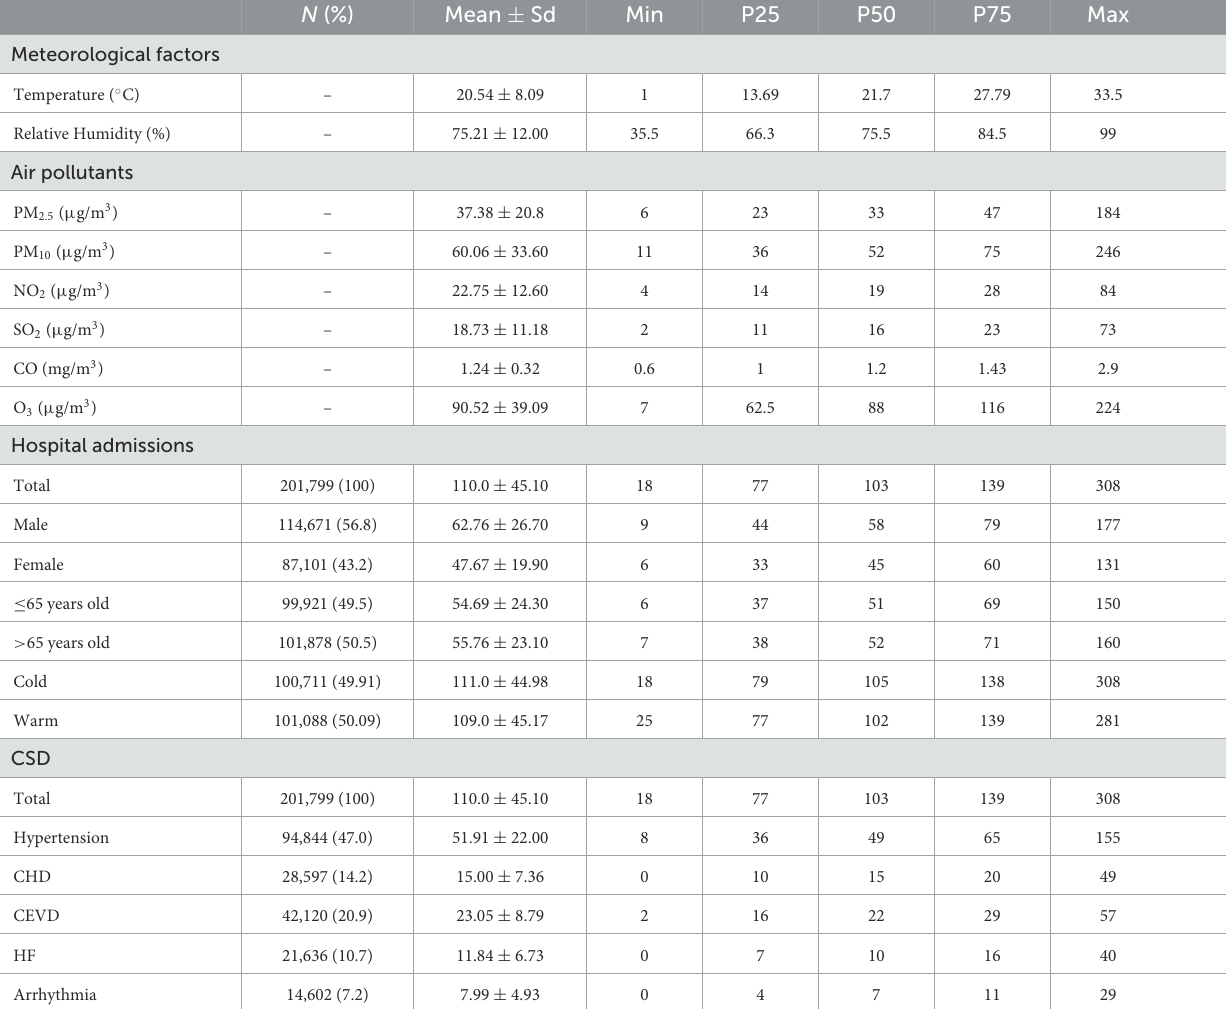
TABLE 1 Characteristics of meteorological variables, ambient air pollutants, and hospital admissions in Ganzhou